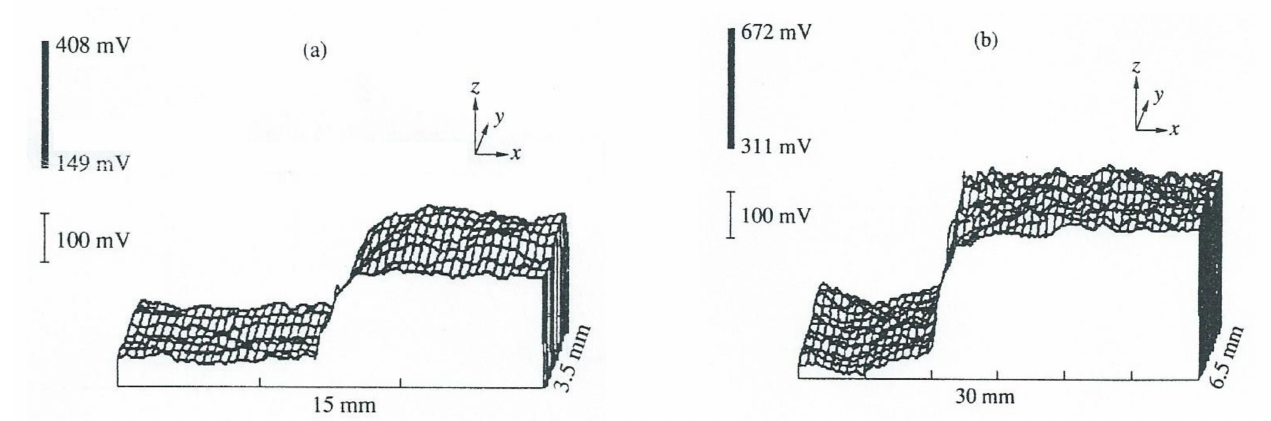
Figure 9. The potential distribution above the iron surface with vapour phase adsorbed BTMS (right-hand side). ( a )— adsorption in the air at 20% RH and ( b )—adsorption in the air at 100% RH. SKP measurements were performed in ambient air at 60%RH and the potential is given vs. SHE [22]. Published with permission from Pleiades Publishing,